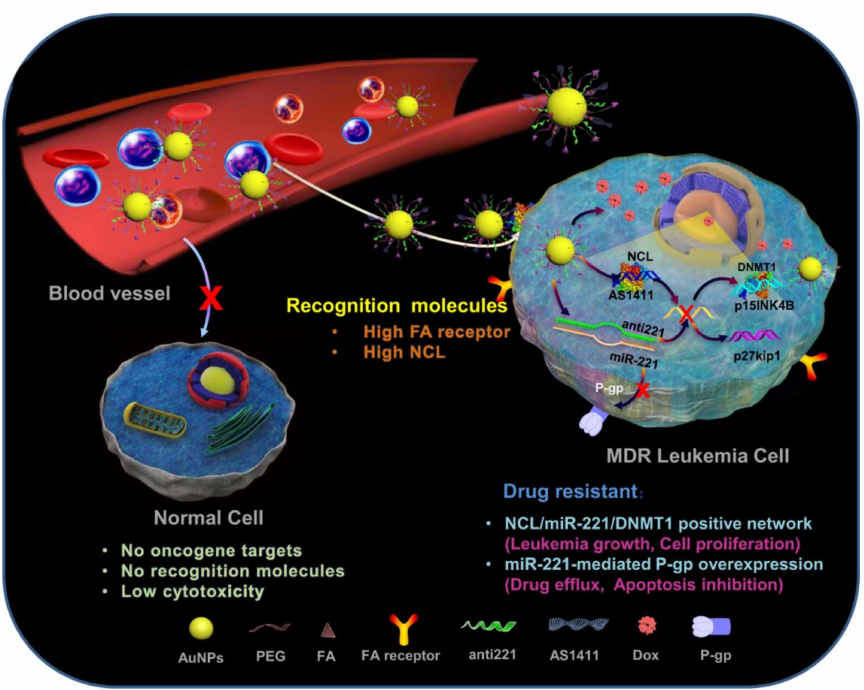
Figure 9. Multifunctional AuNPs target miR-221 network as well as P-gp. These multifunctional AuNPs can overcome P-gp-mediated multidrug-resistance in leukemia cells. The figure is reprinted from Deng et al. (2019) [120]. This study is under Creative Commons Attribution 4.0